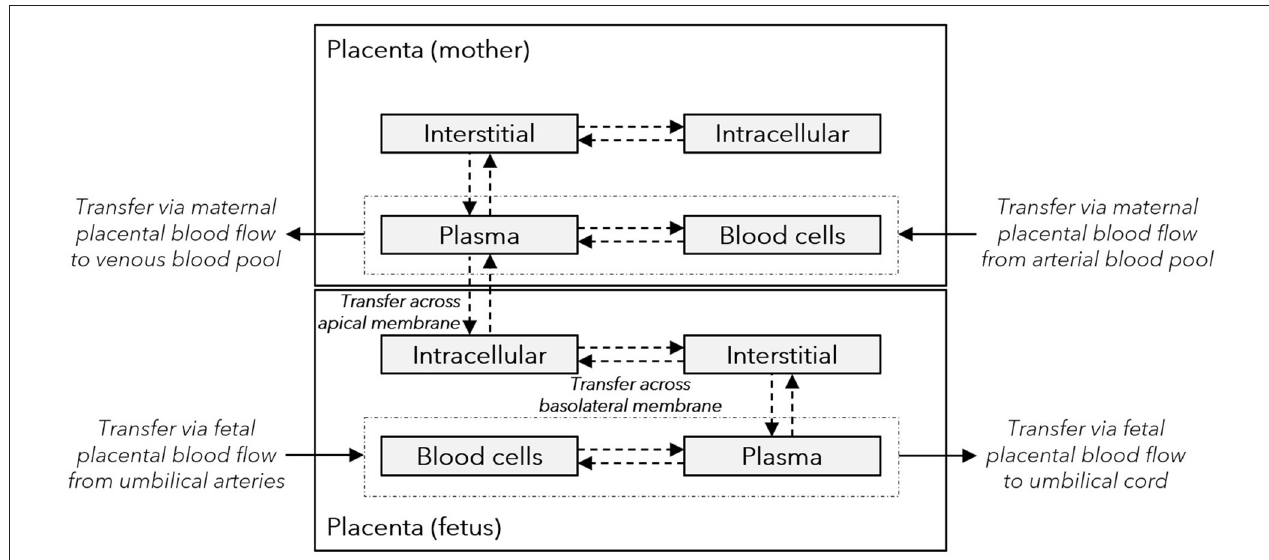
FIGURE 2 | Structure of the placenta sub-model integrated in the maternal-fetal PBPK model. Gray boxes represent sub-compartments of the placenta structure implemented in the maternal-fetal physiologically based pharmacokinetic (PBPK) model; dash-dotted boxes represent the vascular space; solid arrows denote drug transport via the organ blood flow; and dashed arrows denote drug transport via passive diffusion. The maternal plasma and blood cell compartments represent the intervillous space, and the maternal interstitial and intracellular space represent the placental septae and the decidua basalis, respectively. The fetal intracellular compartment represents the (syncytio-)trophoblasts with the apical membrane facing the maternal plasma compartment and the basolateral membrane facing the fetal interstitial compartment. The fetal interstitial space represents intravillous fibrous tissue and the plasma and blood cell compartments represent the intravillous vascular